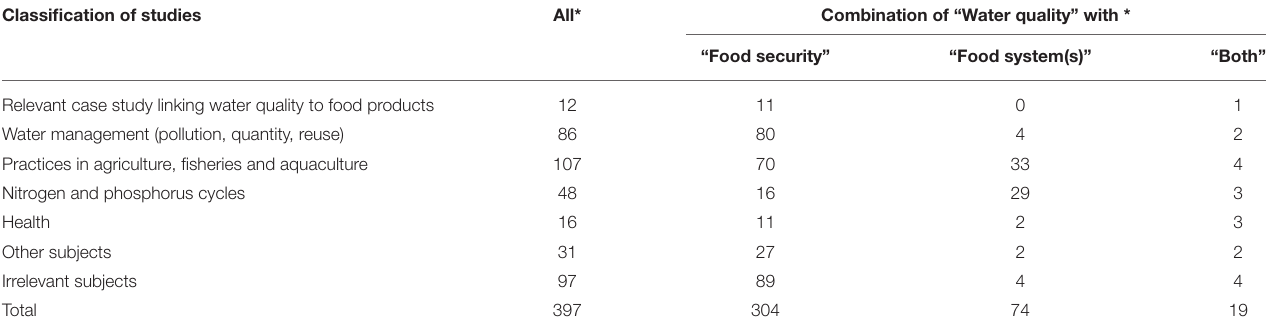
“Food security” “Food system(s)” “Both”